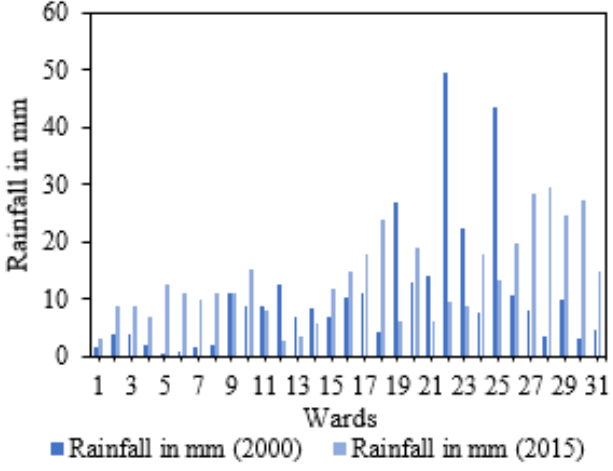
Figure 4. Daily rainfall situation (June 2000 and 2015).